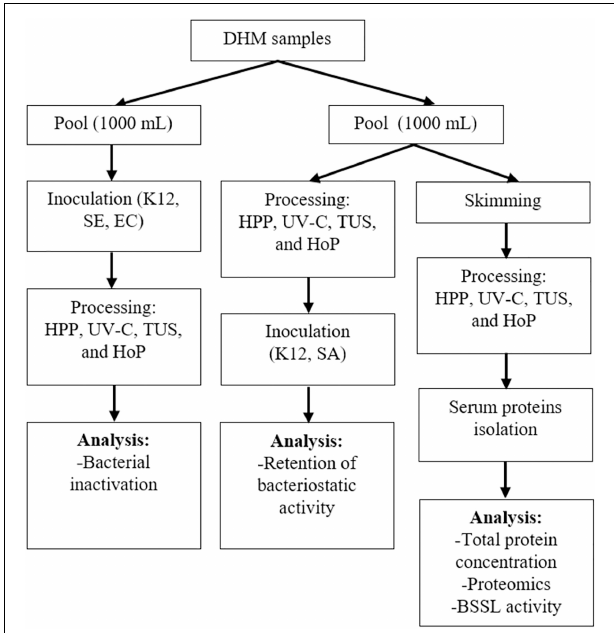
FIGURE 1 | Schematic representation of the experimental approach used. K12, SE, and EC stand for E. coli K12, S. epidermidis and E. cloacae , respectively. Two independent experiments (biological replicates) were performed while all analyses were performed in technical duplicate for each